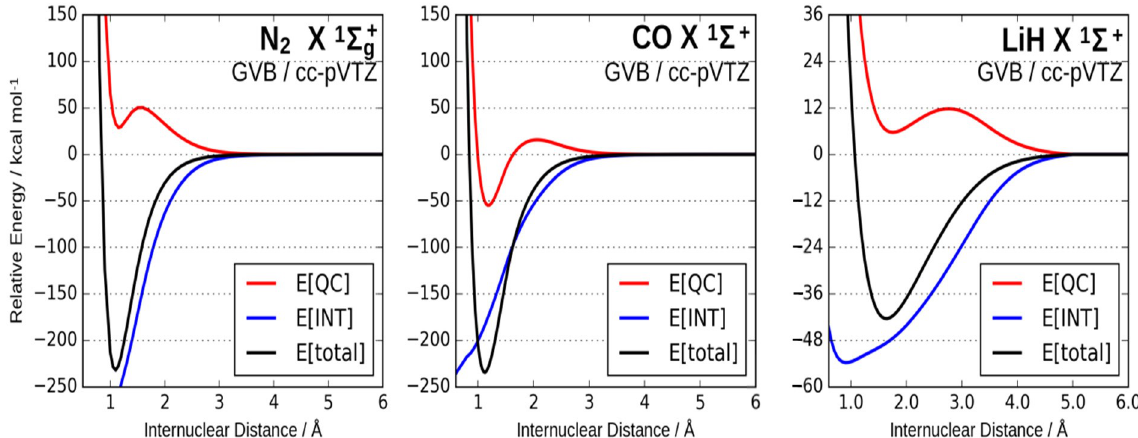
Figure 3. Energy partitioning into interference and quasi-classical contributions along the potential energy surfaces (PES) of N 2 ( μ = 0.0 D), CO ( μ = 0.120 D) and LiH ( μ = 5.882 D).